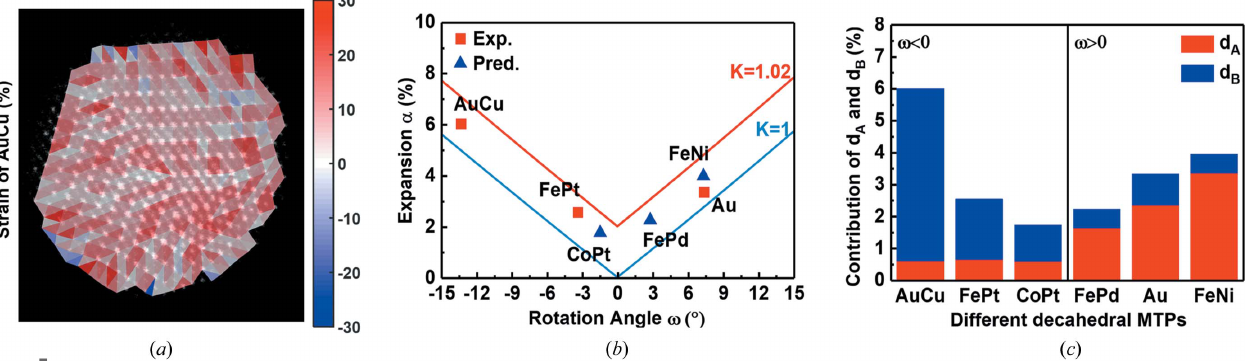
Figure 5 Strain distribution and analysis of lattice distortions. ( a ) Two-dimensional lattice strain map of the AuCu intermetallic decahedral MTP. ( b ) Strain of decahedral MTPs plotted as a function of the disclination rotation angle for both experimental and predicted MTPs. The two lines are the (cid:2) – ! relationship when K = 1.02 (red) and K = 1 (blue). (c) Histogram of the d A and d B contribution to the expansion for both experimental and predicted